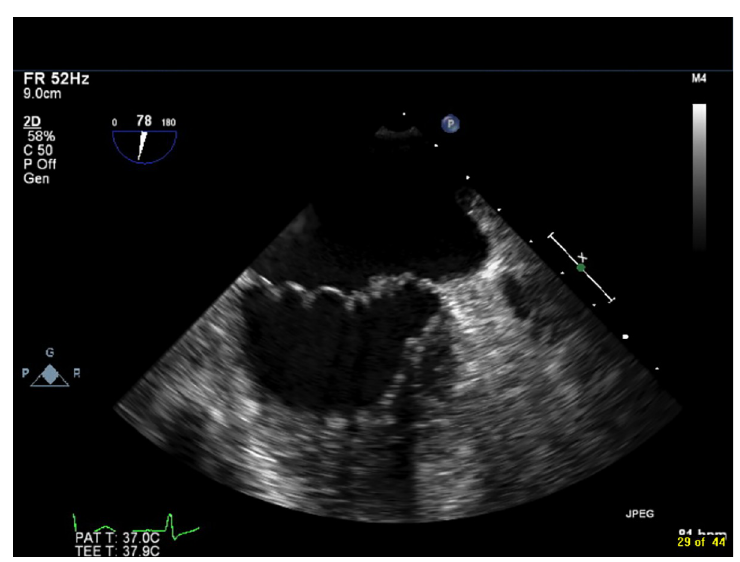
Fig 1. Example of a small fixed mitral valve vegetation (Grade 1 for both mobility and extent).